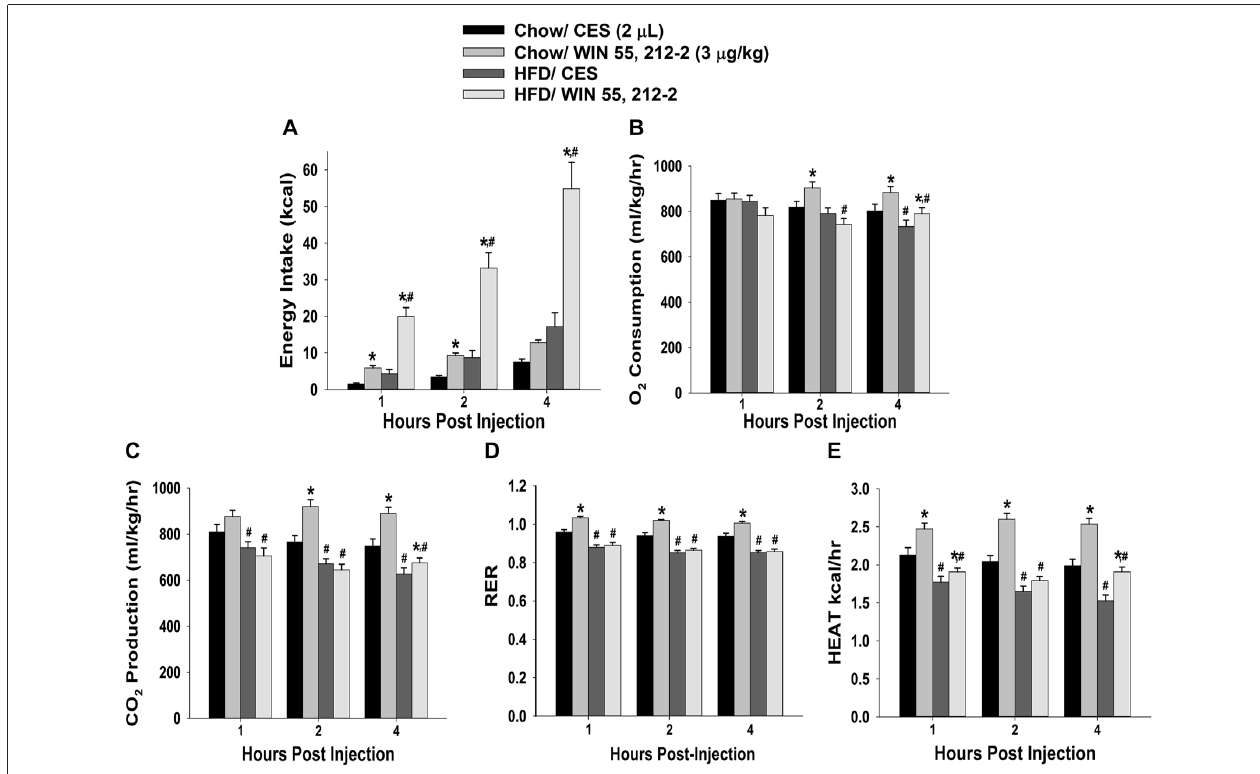
FIGURE 1 | High-fat diet (HFD) potentiates cannabinoid-induced changes in energy intake and but not energy expenditure, in male guinea pigs. Bars represent means and vertical lines 1 SEM of the cumulative energy intake (A) , O 2 consumption (B) , CO 2 production (C) , respiratory exchange ratio (RER; D) and metabolic heat production (E) , which were measured 1, 2 and 4 h after administration of the cannabinoid receptor agonist WIN 55,212-2 (3 µ g; I.3.V) or its cremephor/ethanol/0.9% saline (CES) vehicle (2 µ L; I.3.V). ∗ P < 0.05 relative to CES treated animals; multifactorial analysis of variance (ANOVA)/least significant difference (LSD); n = 5. # P < 0.05 relative to chow-fed animals; repeated measures, multifactorial ANOVA/LSD; n =